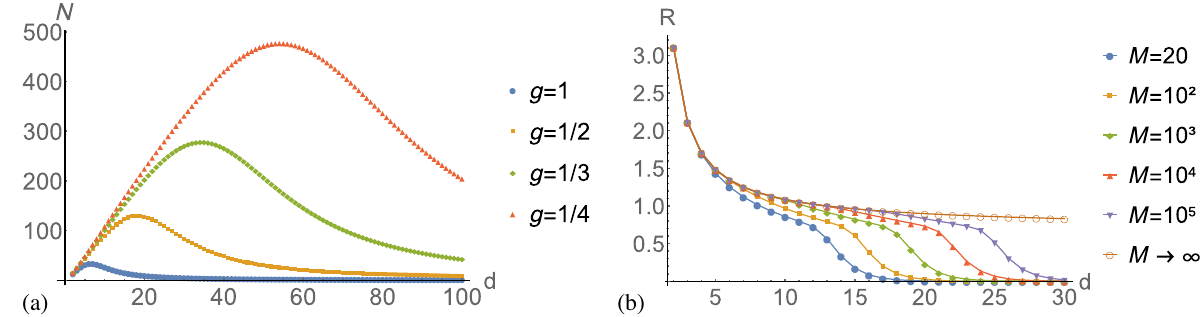
FIG. 7. (a) The accuracy is shown as a function of d for different values of g (and fixed c ¼ 10 s − 1 ), where ½ g (cid:2) ¼ E achievable accuracy increases with decreasing g . (b) The resolution is shown as a function d (at fixed g ¼ 1 E lines with solid dots show cases of finite M . The line with orange circles illustrates the behavior for the case M → ∞ , which provides an upper bound to the cases with finite M . For finite M , increasing d reduces the top-level population, eventually becoming so small that the decay event is considerably more likely to skip the first peak of P initiating a drop of the resolution eventually approaching 0 (with d ).